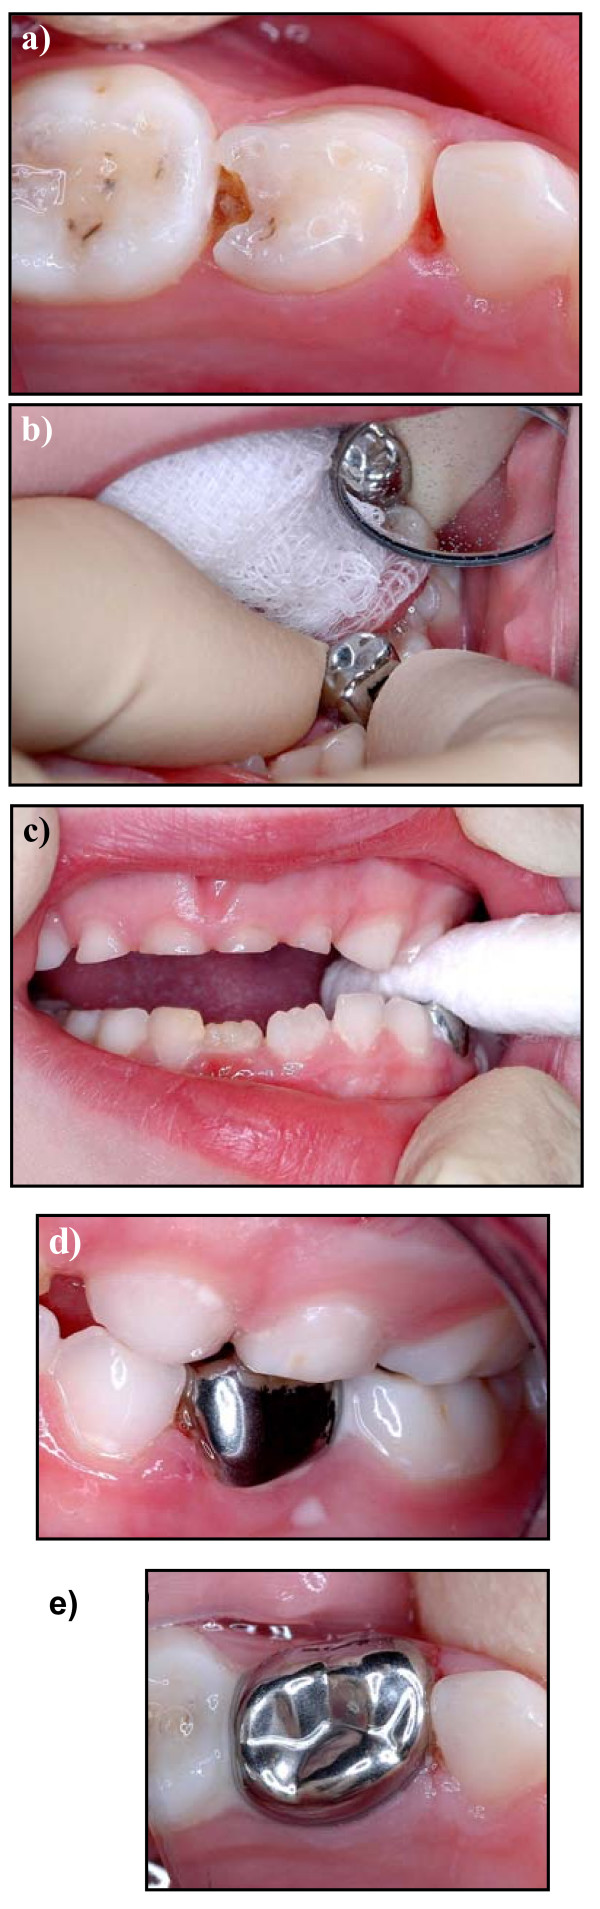
Clinical photographs of a Hall PMC being fitted: a) carious primary molar tooth 74 (LLD) to be fitted with a Hall PMC; b) PMC being tried over occlusal surface of tooth to guage size (guaze providing airway protection). The crown is now filled with glass ionomer cement and placed firmly over the tooth; c) patient biting on cotton roll to push crown between contact points and maintain pressure until cement sets; d) buccal view, and e) occlusal view of the fitted Hall PMC.